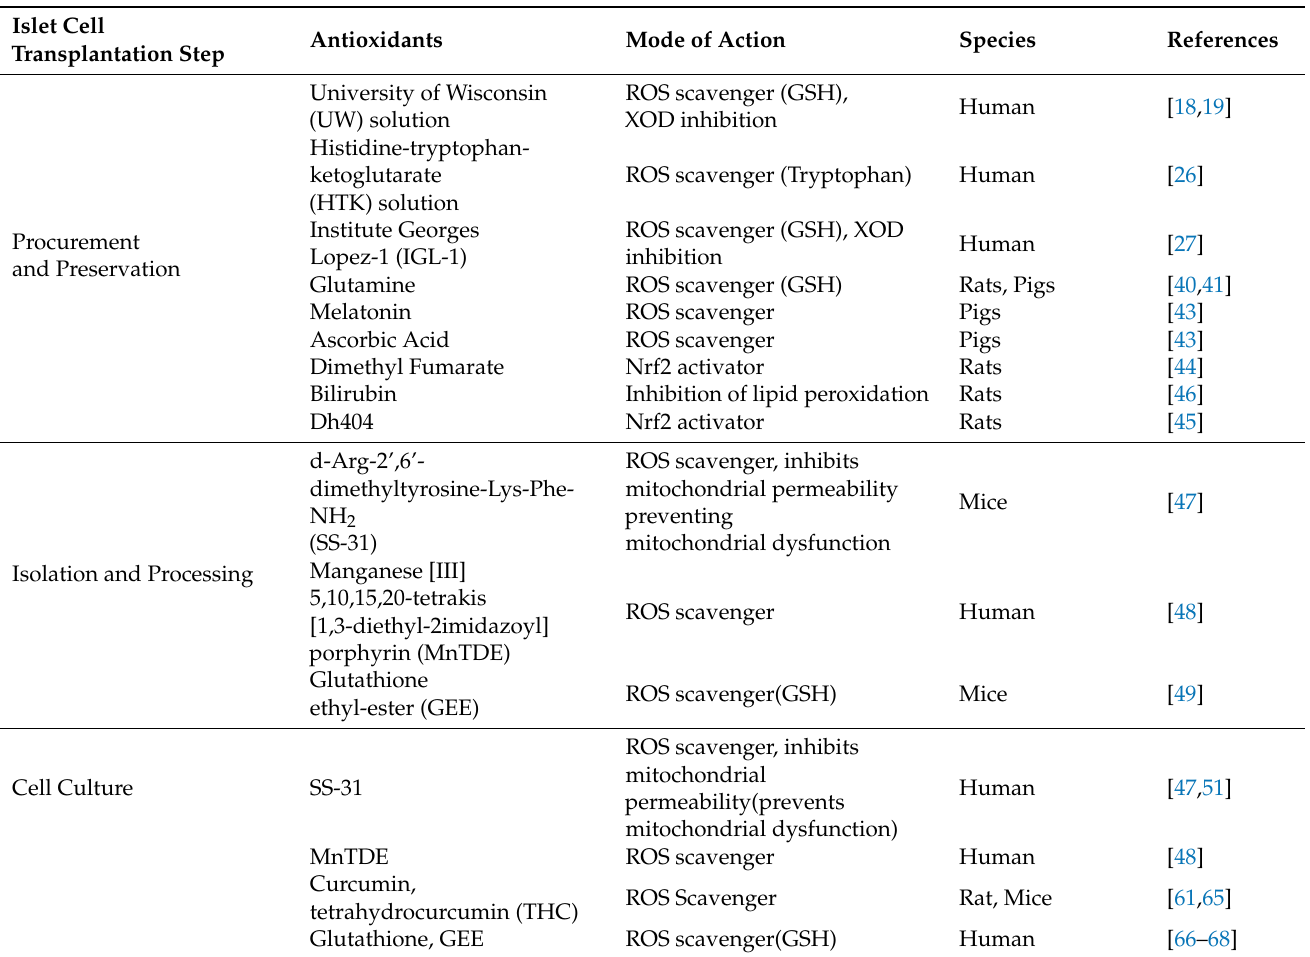
Table 1. Table of antioxidants discussed in this review paper: GSH, reduced glutathione; XOD, xanthine oxidase; GPx, glutathione peroxidase; MnSOD, manganese superoxide dismutase;